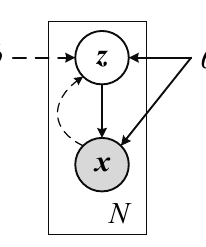
Figure 2. Graphical model of VAE. Without loss of generality, x ∈ R D stands for input data, z ∈ R K is the latent variable, where D and K are the dimension of the input and that of the latent variable, respectively. The solid line denotes generative process (decoder) and the dash lines denote variational approximation